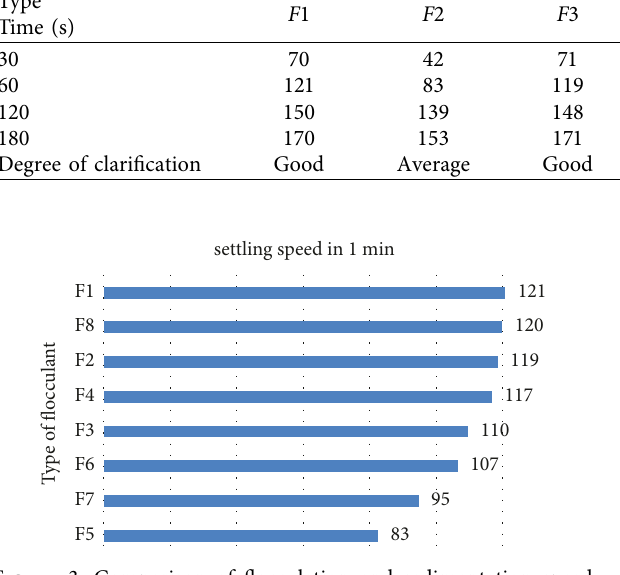
Figure 3: Comparison of flocculation and sedimentation speed (unit: mm/min).